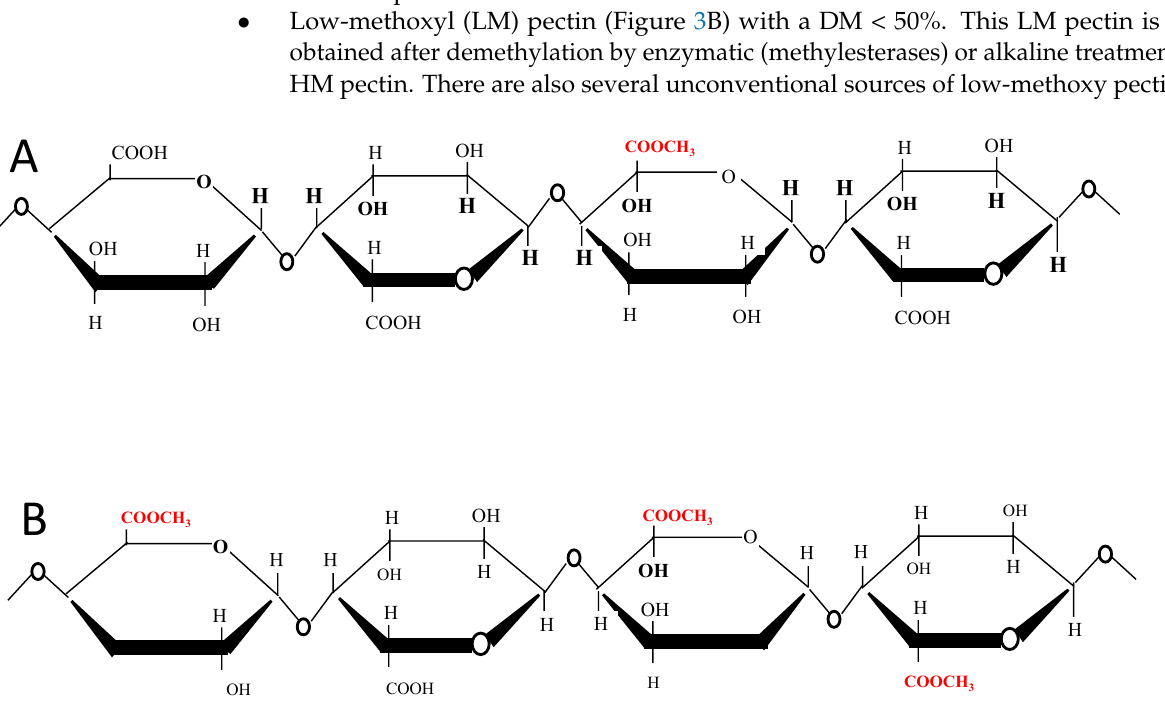
Figure 3. Partially methylated galacturonans. ( A ) Low-methoxyl and ( B ) high-methoxyl pectin structures [11].